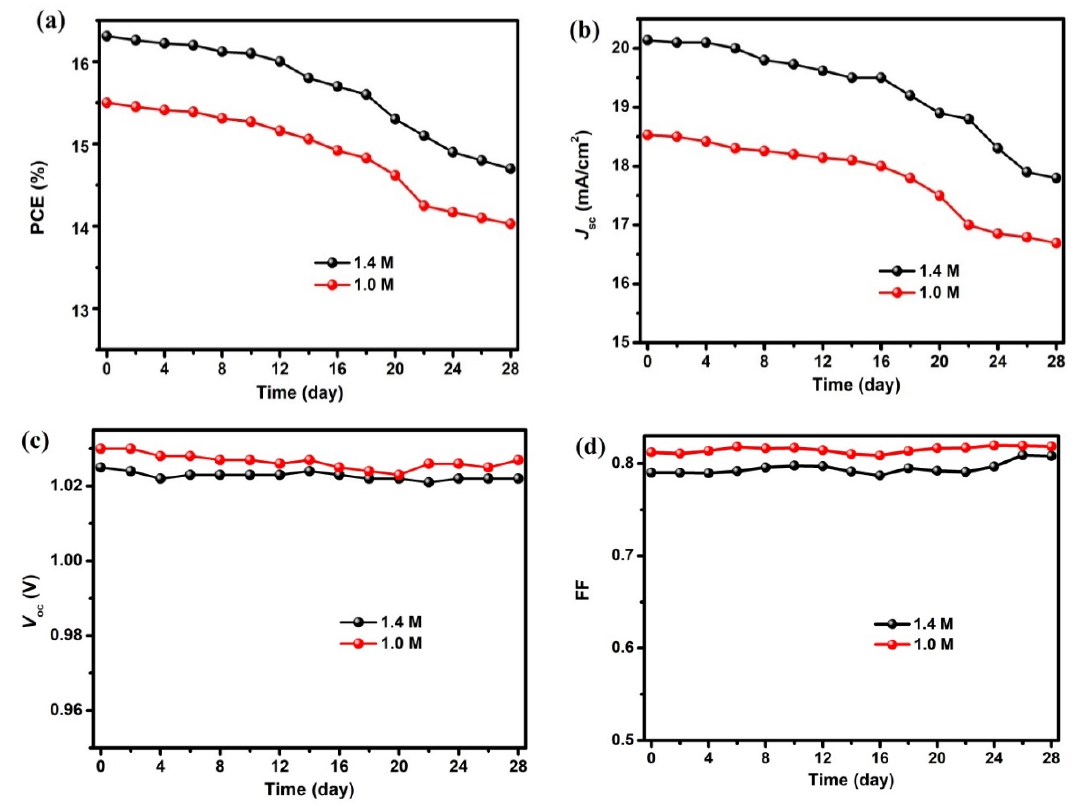
Figure 4. The stability of the 1 M-20 nm device and reference device stored in a glove box: ( a ) PCE , ( b ) J SC , ( c ) V OC and ( d ) FF